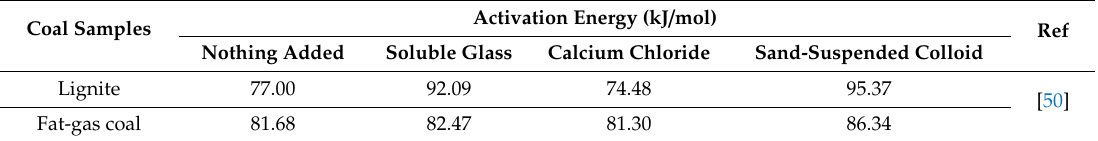
Table 2. Activation energy of coal